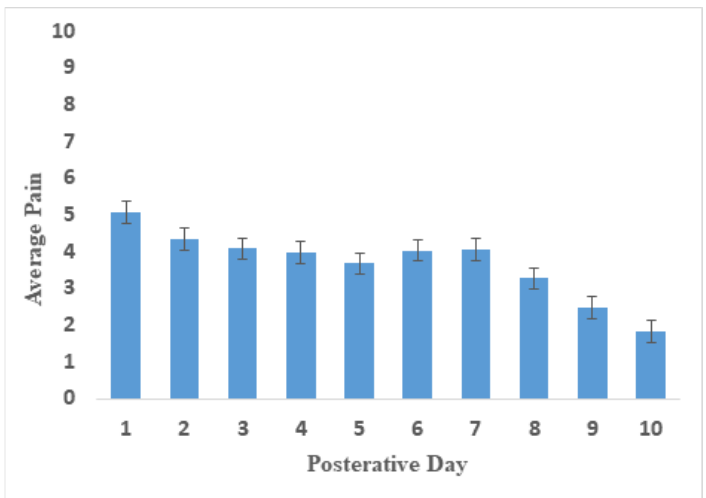
Figure 2. Average daily pain in the first 10 days after surgery. Abbreviations: CI, confidence interval. Average daily pain in the first 10 days after surgery. Error bars indicate 95% CIs. Table 2. Average posterior probabilities of group assignment and Bayesian Information Criterion (BIC) statistics of trajectory model